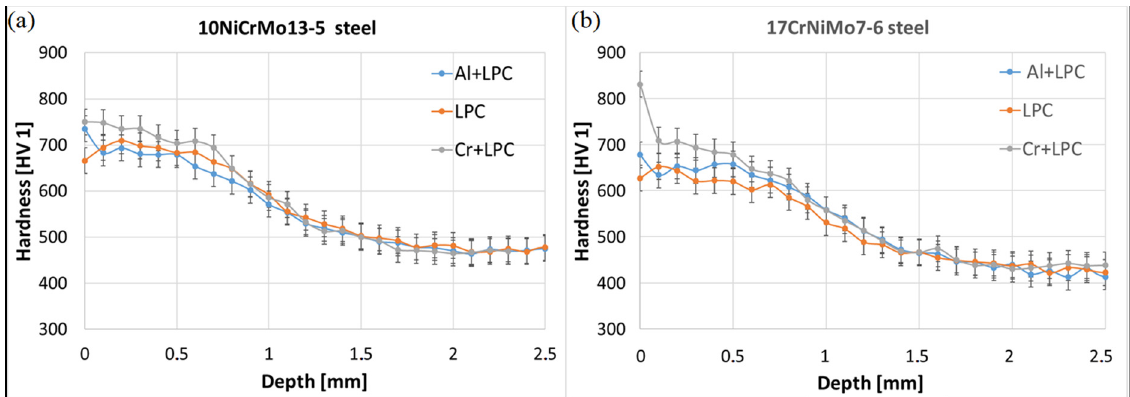
Figure 5. Hardness distribution for 10NiCrMo13-5 ( a ) and 17CrNiMo 7-6 ( b ) steels after low pressure carburizing only, after low pressure carburizing with chromium plating and after low pressure carburizing with aluminum coating.